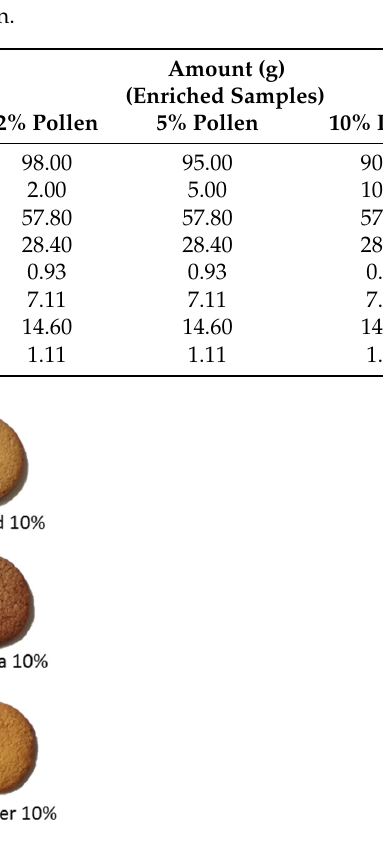
Figure 1. Biscuit samples after baking.